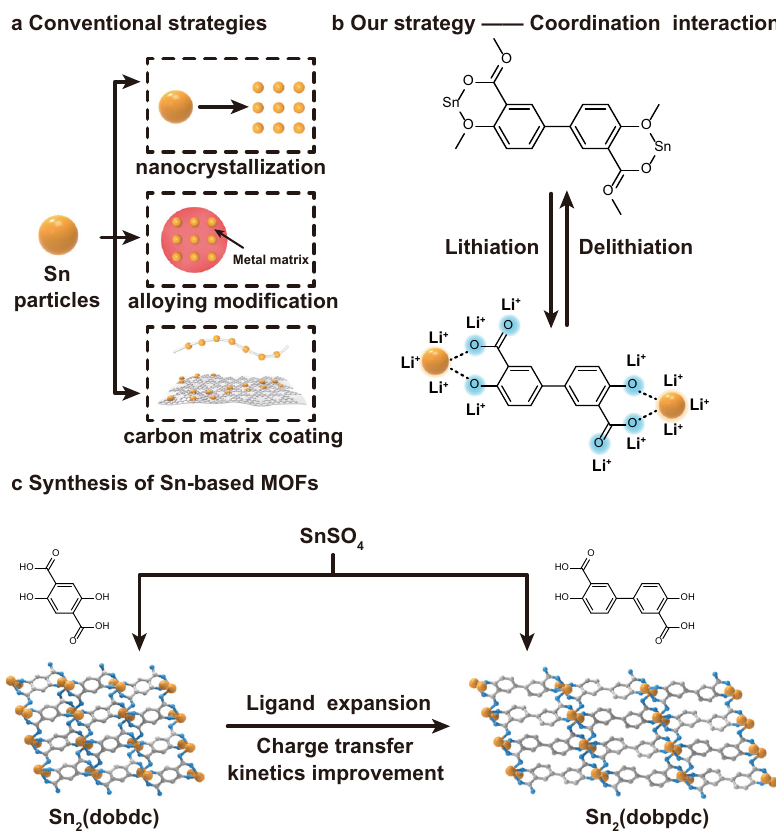
Fig. 1 Synthetic strategy for Sn-based MOFs as anode materials. a Three conventional strategies for Sn-based anode materials: nanocrystallization, alloying modi fi cation and carbon matrix coating. b Our strategy uses Sn-based MOFs for reversible lithium storage. c Schematic illustration of the synthesis of Sn 2 (dobdc) and Sn 2